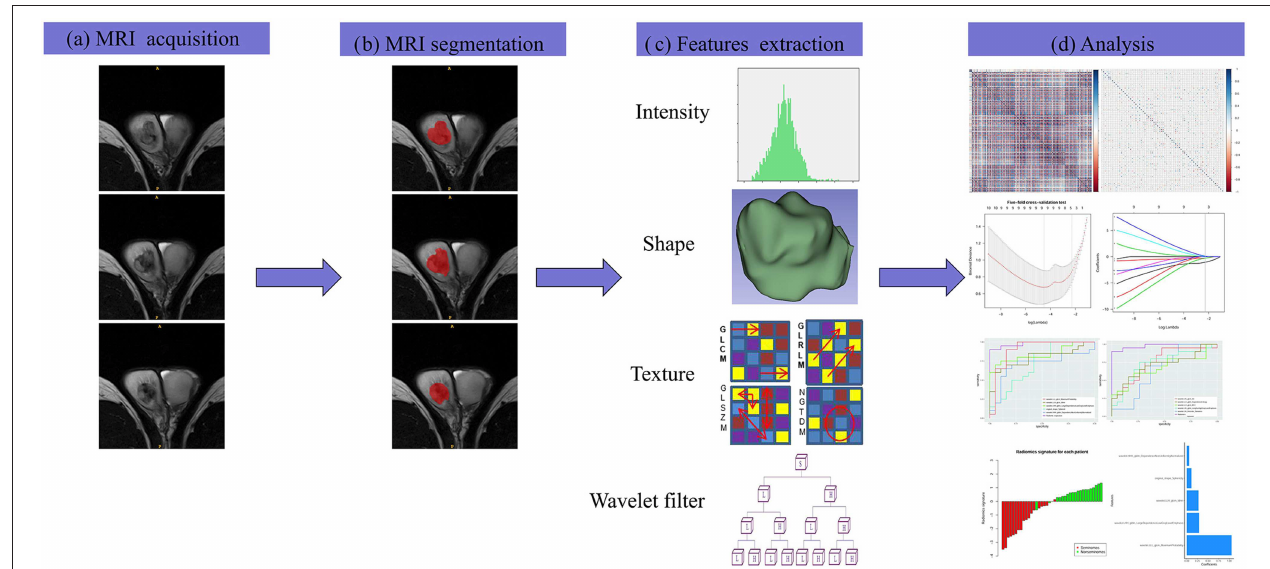
FIGURE 2 | The framework for the radiomics workflow. (a) All patients were scanned with preoperative MRI. (b) Tumors were delineated by stacking regions of interest slice-by-slice on the transverse T2WI. (c) Radiomics features were extracted from the T2WI in a high-throughput manner. (d) Data analysis for the features selection and a radiomics signature construction.